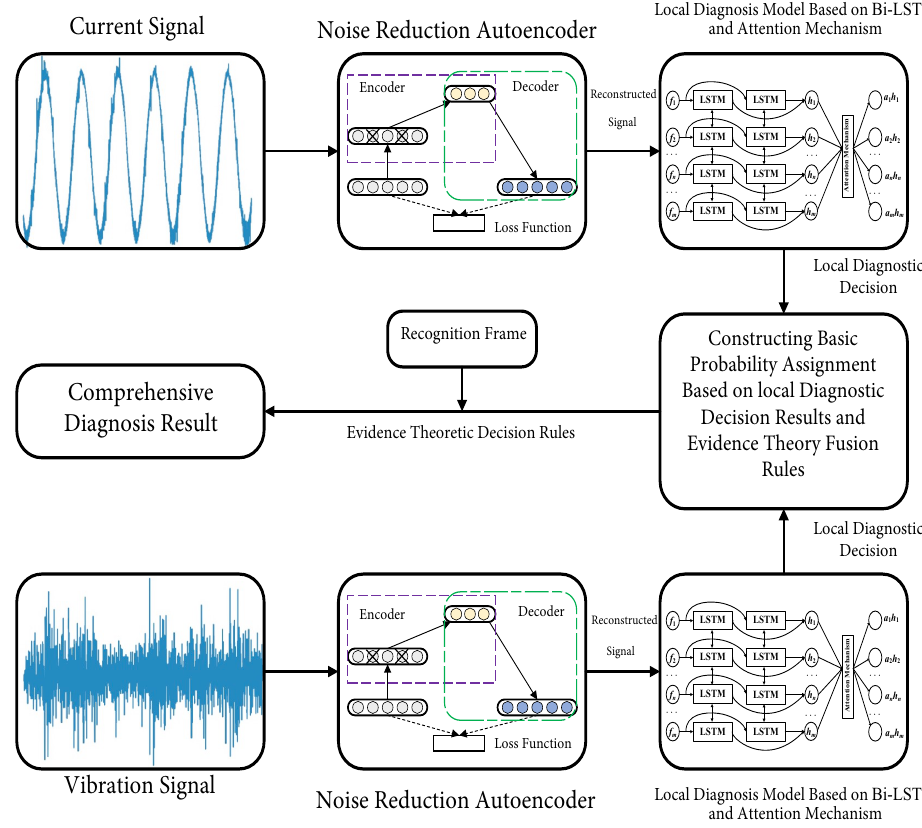
Figure 1. Structure diagram of multi-local fault diagnosis model based on